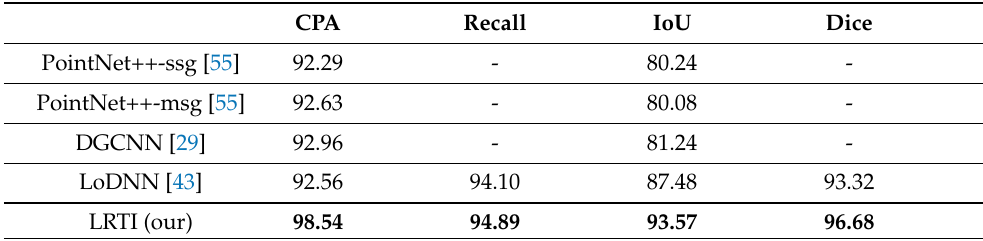
Table 3. Quantitative evaluation of different methods. The bold is the highest indicator of comparison